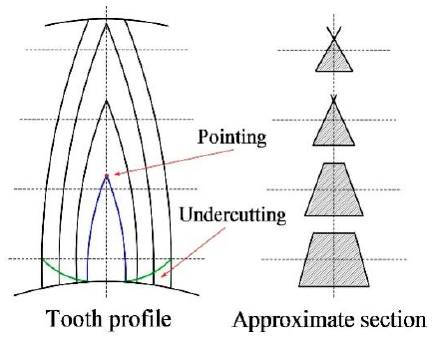
Figure 1. Approximate tooth profile of face